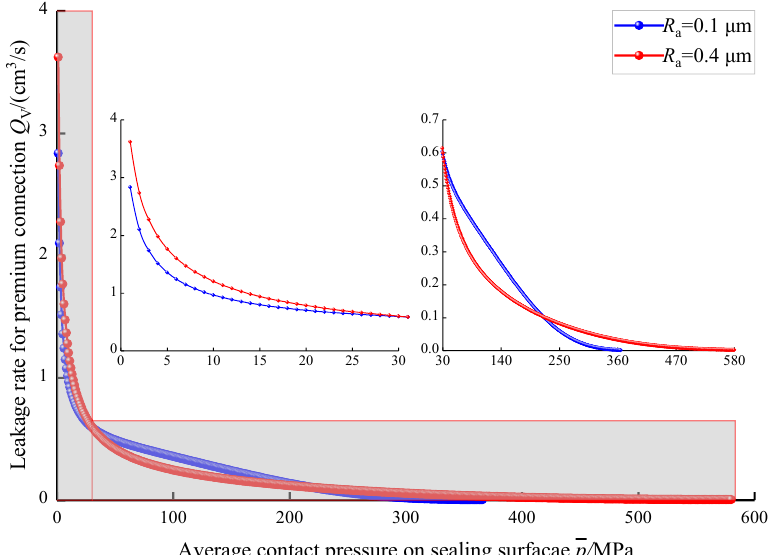
Figure 9. Influence of average contact pressure on sealing surface on leakage rate for two roughness values.